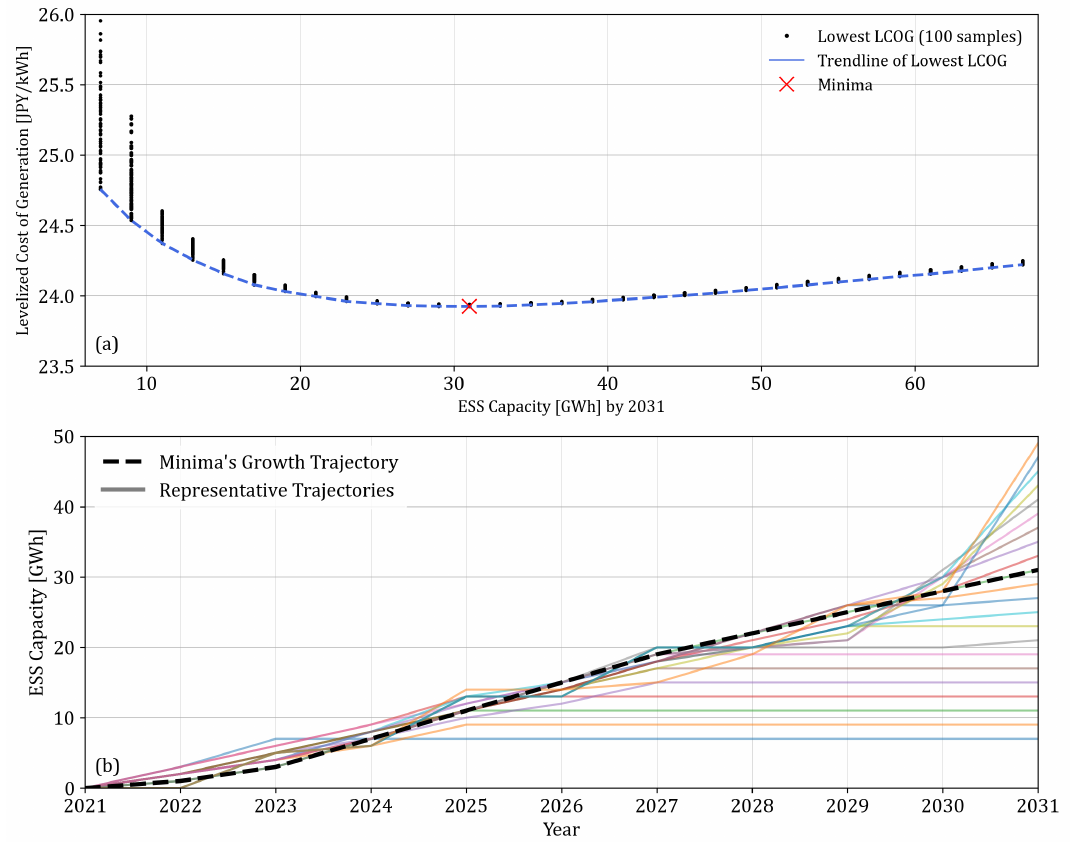
Figure 13. ( a ) Minimum LCOG per max ESS capacity in 2031. ( b ) Growth trajectory of the samples with the lowest LCOG sorted according to the ESS capacity by 2031 ( ESS cap ). In ( b ), the minima’s (optimal) trajectory is shown as a dashed line 2031 and the representative trajectories are shown as faded solid